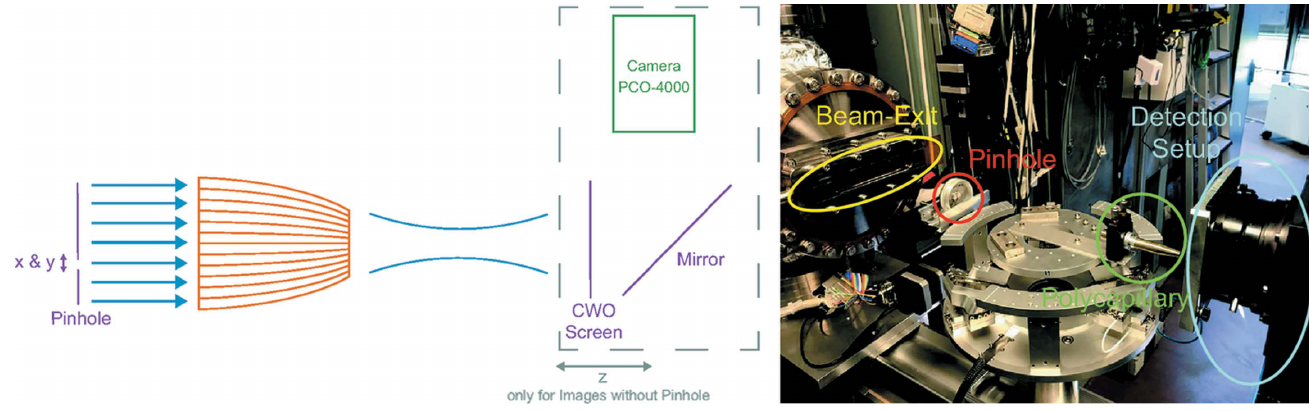
Figure 2 Experimental setup on the BAMline beamline at the BESSY II synchrotron, at the HZB.